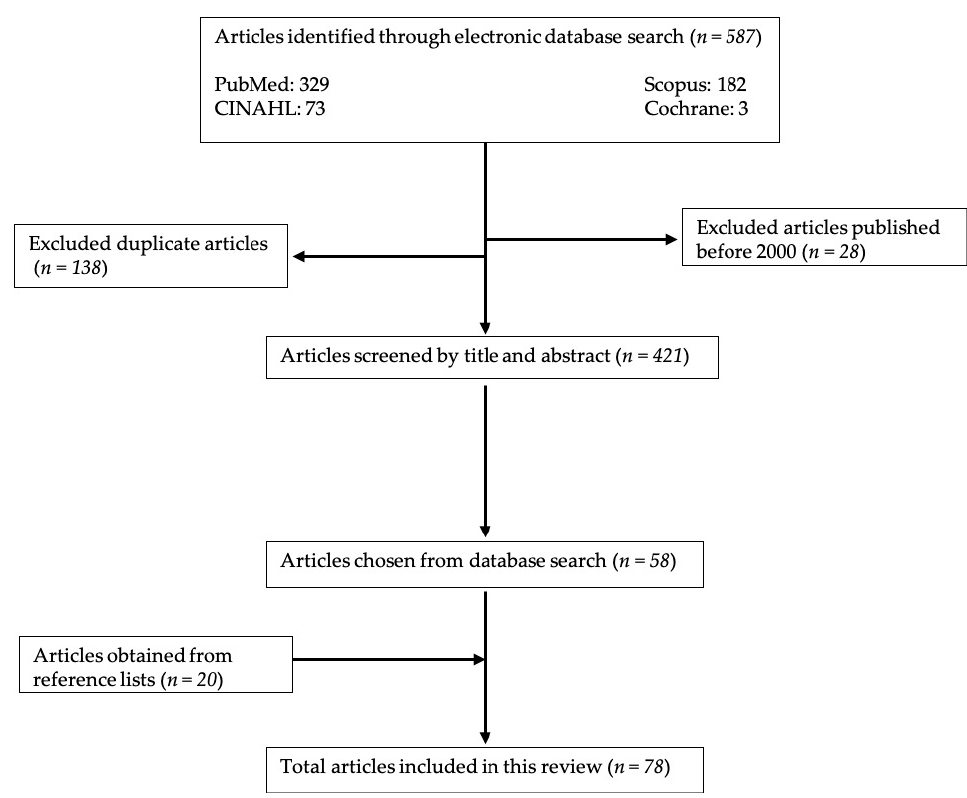
Figure 1. Methods process flow chart.